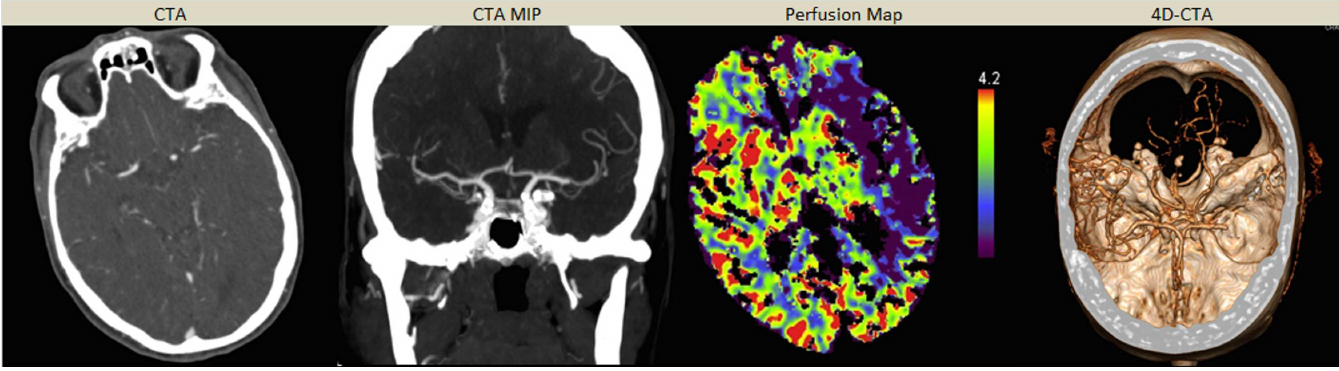
Fig 1. Reviewing example of a patient that presented to the ER with right-sided hemiplegia and dysarthria. A difficult to read CTA due venous enhancement just siding the right MCA was performed, and intra-cranial vessels where initiallydeclaredpatent. Only when reviewingthe 4D-CTA data, the patient was transferred to the angio-suitefor IA therapy. Below figs shows consecutively CTA, coronalMIP view, perfusion map and a freeze of the